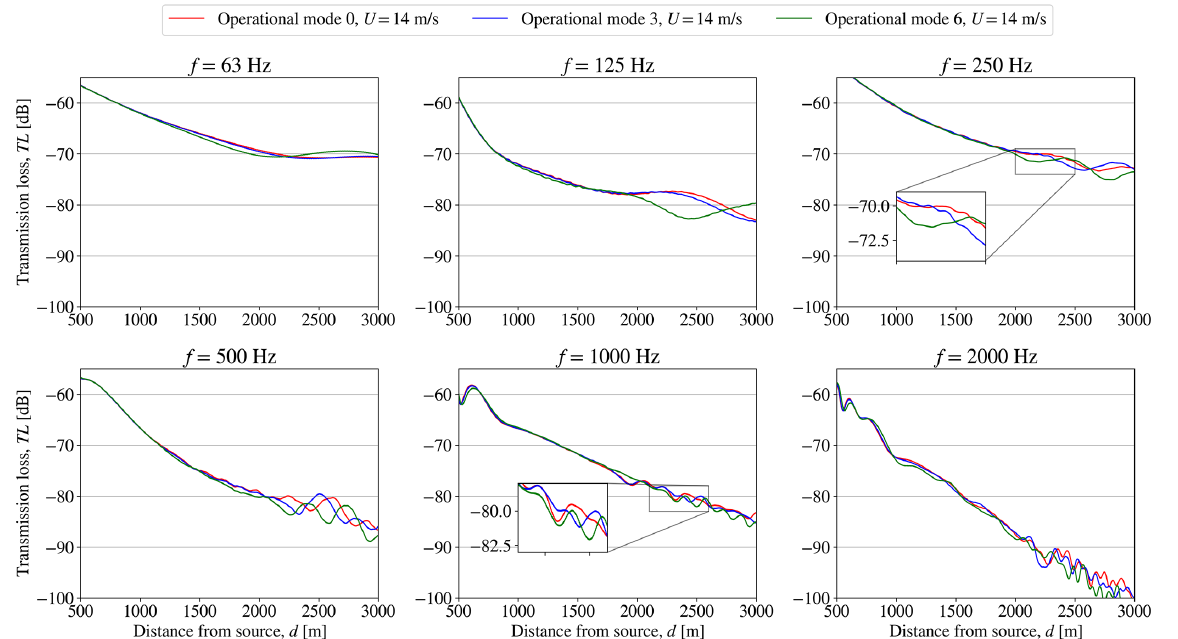
Figure A2. Setup 1: C T sensitivity of WindSTAR obtained transmission loss, TL, from a single wind turbine subject to changing operational modes at each octave band frequency at a free field wind speed of U 0 = 6ms − 1 .